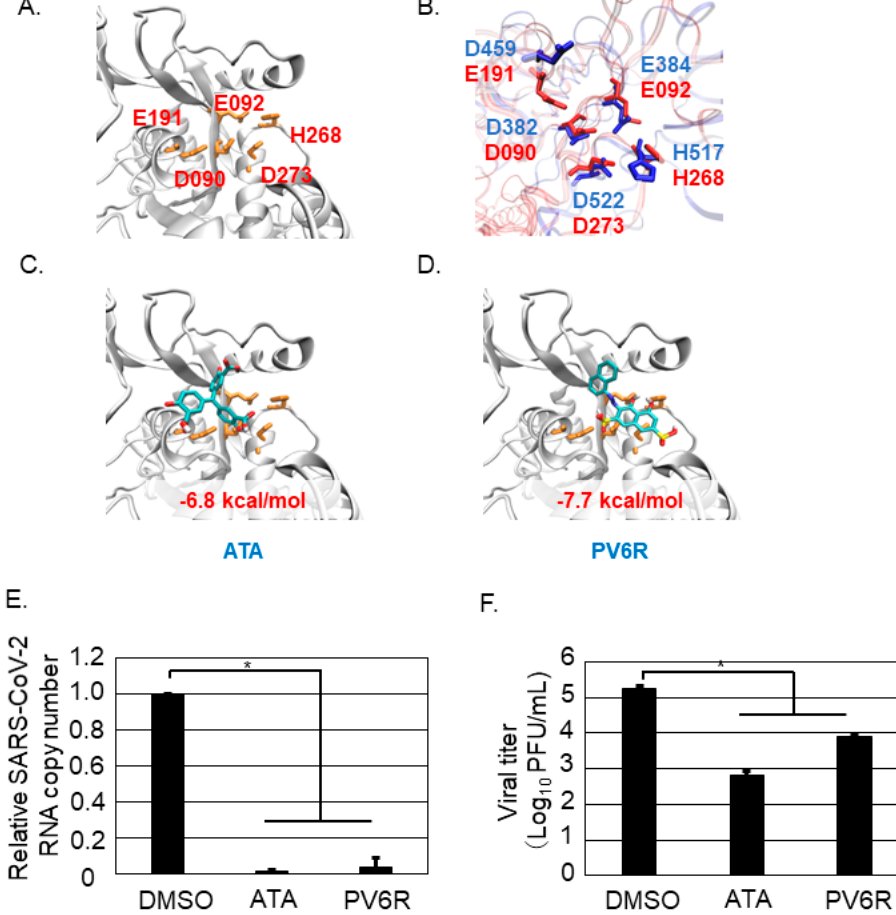
Figure 4. Both ATA and PV6R inhibited SARS-CoV-2 infection and propagation. ( A ) Homology modeling of the DEEDh motif of the SARS-CoV-2 nsp14. Amino acid number which corresponded to the DEEDh motif was described in RED font together with the amino acid number. ( B ) Overlap of the SARS-CoV-2 nsp14 and LCMV NP DED/EDh motifs was shown. Amino acids of the DED/EDh motifs in SARS-CoV-2 nsp14 and LCMV NP were colored in RED and BLUE, respectively. ( C ) Docking simulation of the ATA and the homology model of the SARS-CoV-2 nsp14. ( D ) Docking simulation of the PV6R and the homology model of the SARS-CoV-2 nsp14. Vero 76 cells were infected with SARS-CoV-2 and treated with DMSO, ATA, or PV6R, respectively. The viral copy number in the cells at 24 h p.i. was measured. Relative viral copy number normalized with the DMSO control treatment in Vero 76 cells was shown ( E ). Vero 76 cells were infected with SARS-CoV-2 and treated with DMSO, ATA, or PV6R, respectively, and the viral titer was measured at 48 h p.i. ( F ). Data were collected from at least three independent experiments, and shown data correspond to the mean +/ − SD (* p < 0.05).